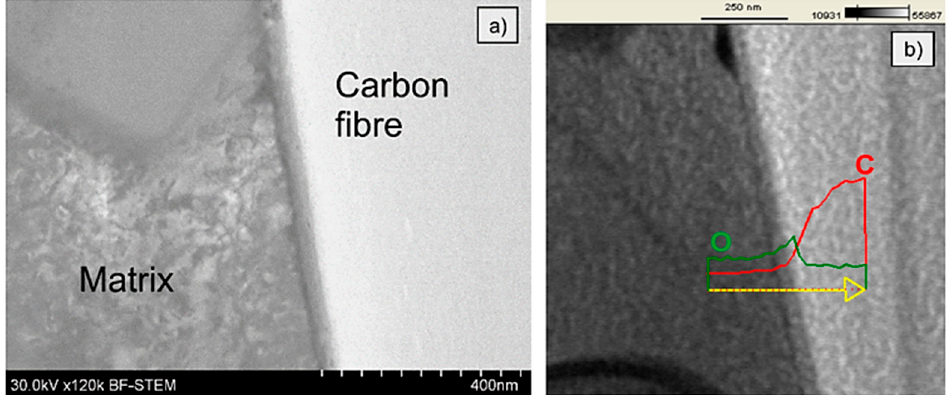
Figure 10. Bright-field TEM image of the interface between carbon fibre and aluminium alloy matrix of MMC1 sample: ( a ) before the push-out test; ( b ) linear EDS analysis.